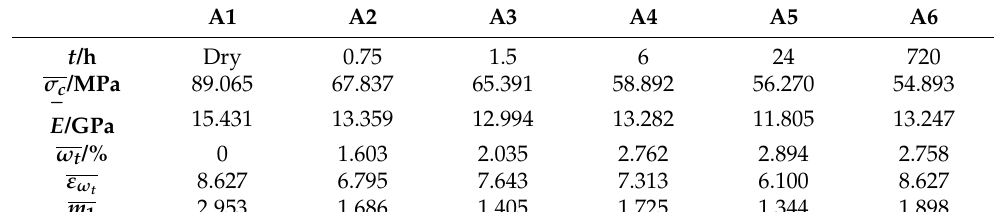
Table 3. The value of m 1 under uniaxial compression status.